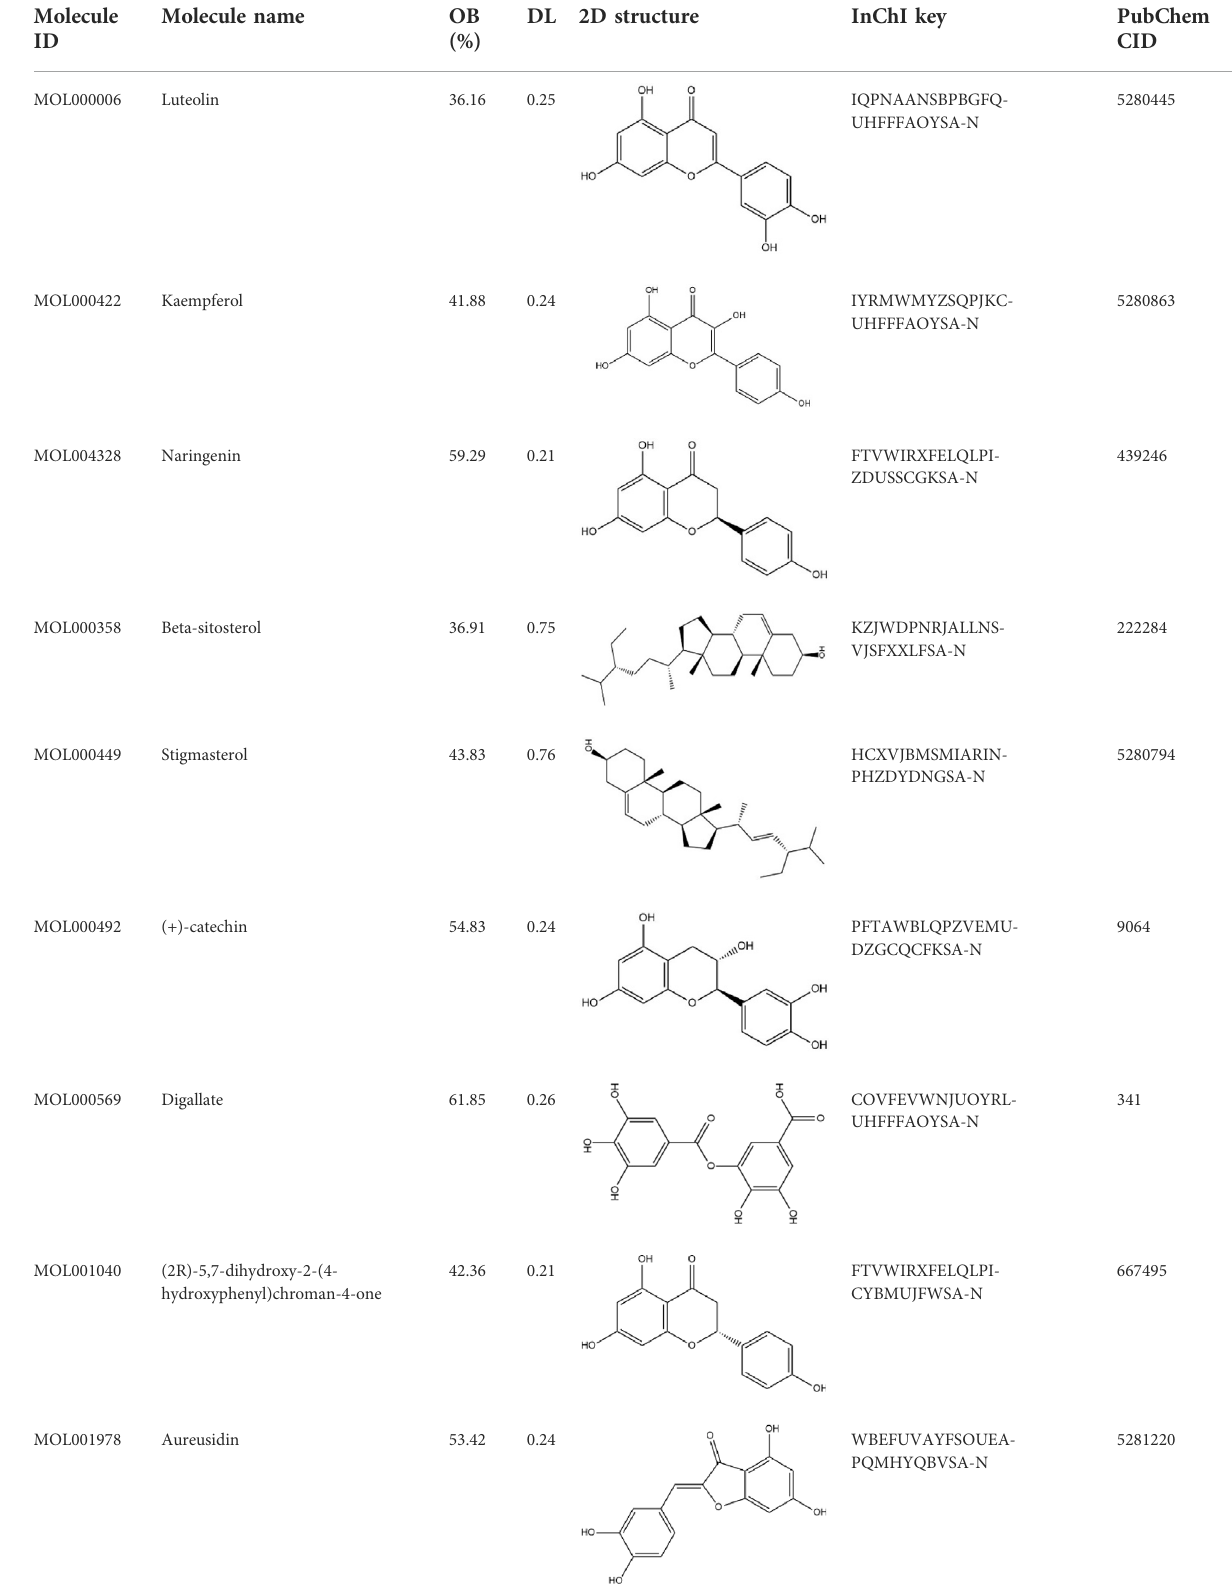
TABLE 1 Basic information of active compounds in